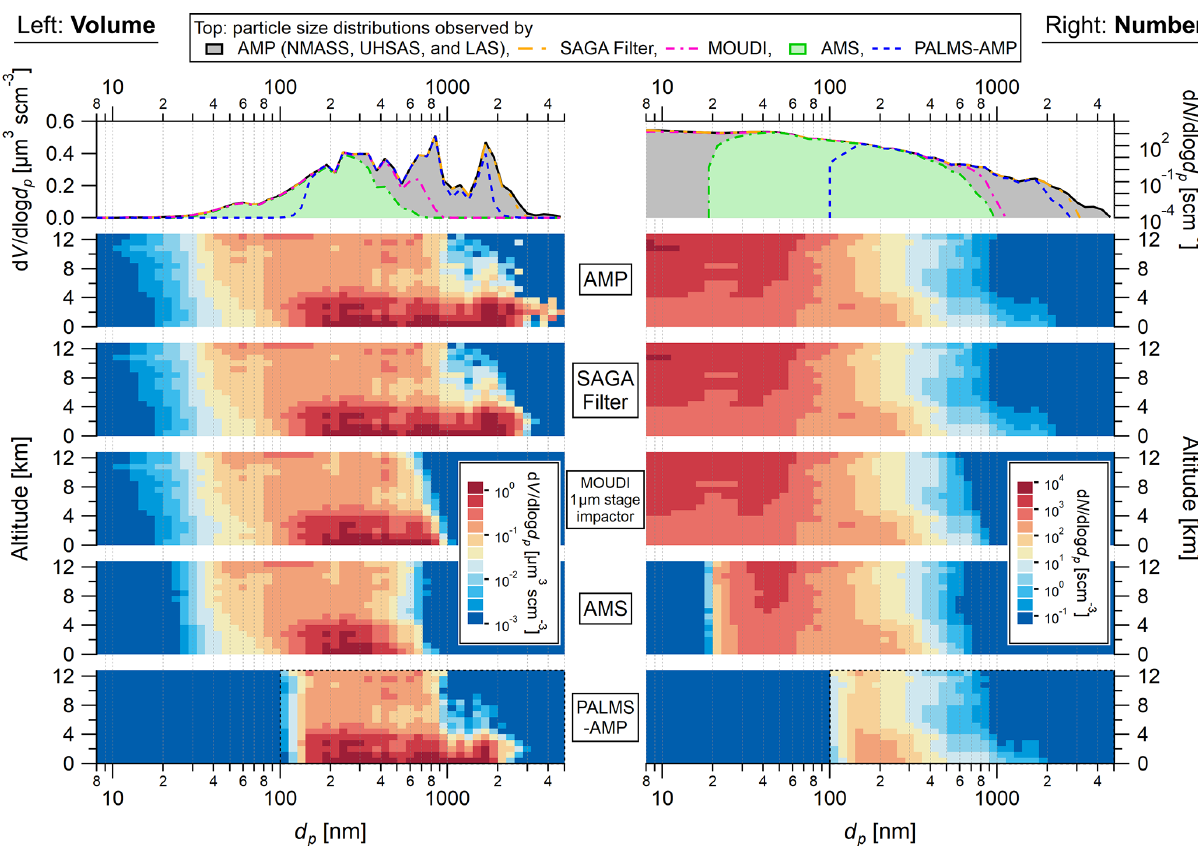
Figure 8. Campaign-averaged volume (left) and number (right) size distributions observed by AMP in ATom-2 (NMASS measured down to 3nm, and here we only show the subrange starting from 8nm), together with the approximate particle size ranges contributing chemical composition information (without consideration of the details of the chemical detection) to the AMS, PALMS, and SAGA filter and size- selected by a MOUDI 1µm stage impactor. The top panel is one dimensional with the campaign-averaged result of each instrument (the transmissions of MOUDI and SAGA filter are altitude dependent and plotted in Figs. 3 and S19, respectively; PALMS effective detection range depends on counting statistics, and the detected particles given a sampling period are discussed in Figs. S15–16). Note that the top panel shows the fraction of the average, while Fig. 7 shows the average fractions (a summary in Table S2). The right plots represent the size ranges of the number size distribution contributing chemical composition information to each instrument. The following panels show the vertical profiles of the same quantities for AMP, SAGA filter, MOUDI impactor, AMS, and PALMS-AMP, respectively. The PALMS-AMP product (Froyd et al., 2019) reports compositions above 100nm, the size range indicated by the dashed square in the bottom panels. The plotted altitude bins are 800m